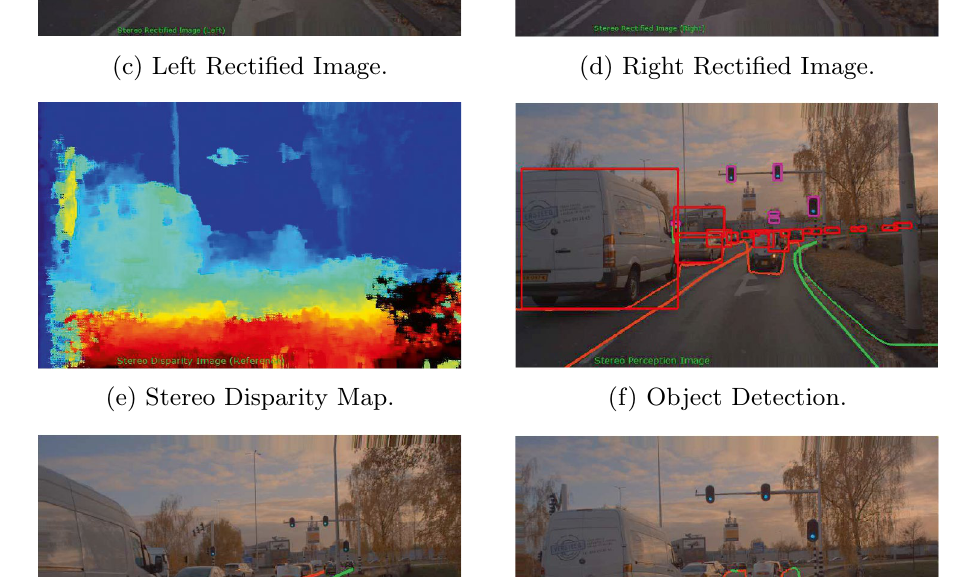
(g) Lane Detection. (h) Free Space